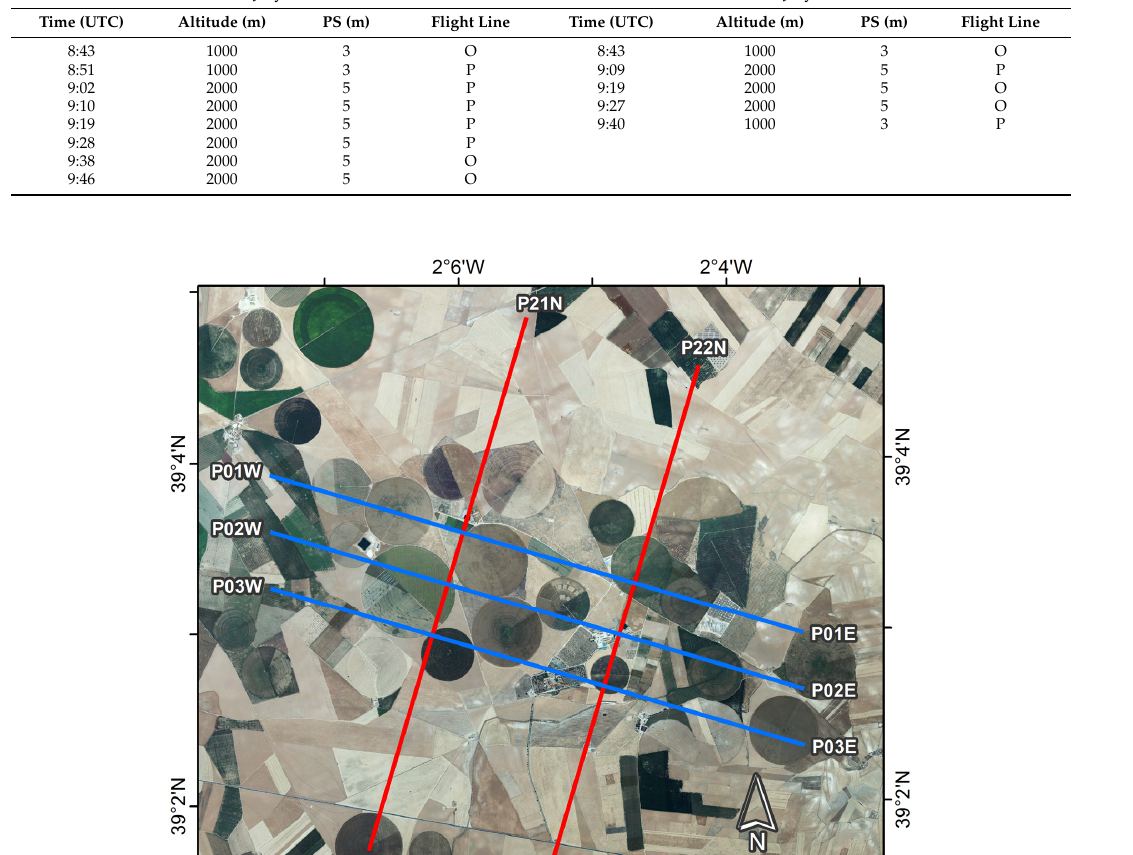
Figure 3. ( a ) Field of View (FOV) of the sensor, Instantaneous Field Of View (IFOV) over target T 1 and View Zenith Angle of two targets (T 1 and T 2 ) for a flight perpendicular to the solar principal plane; ( b ) FOV and position of the targets for a flight parallel to the solar principal plane. VZA 1 , VZA 2 and IFOV in ( b ) lie on the YZ plane and are not shown for the sake of clarity.